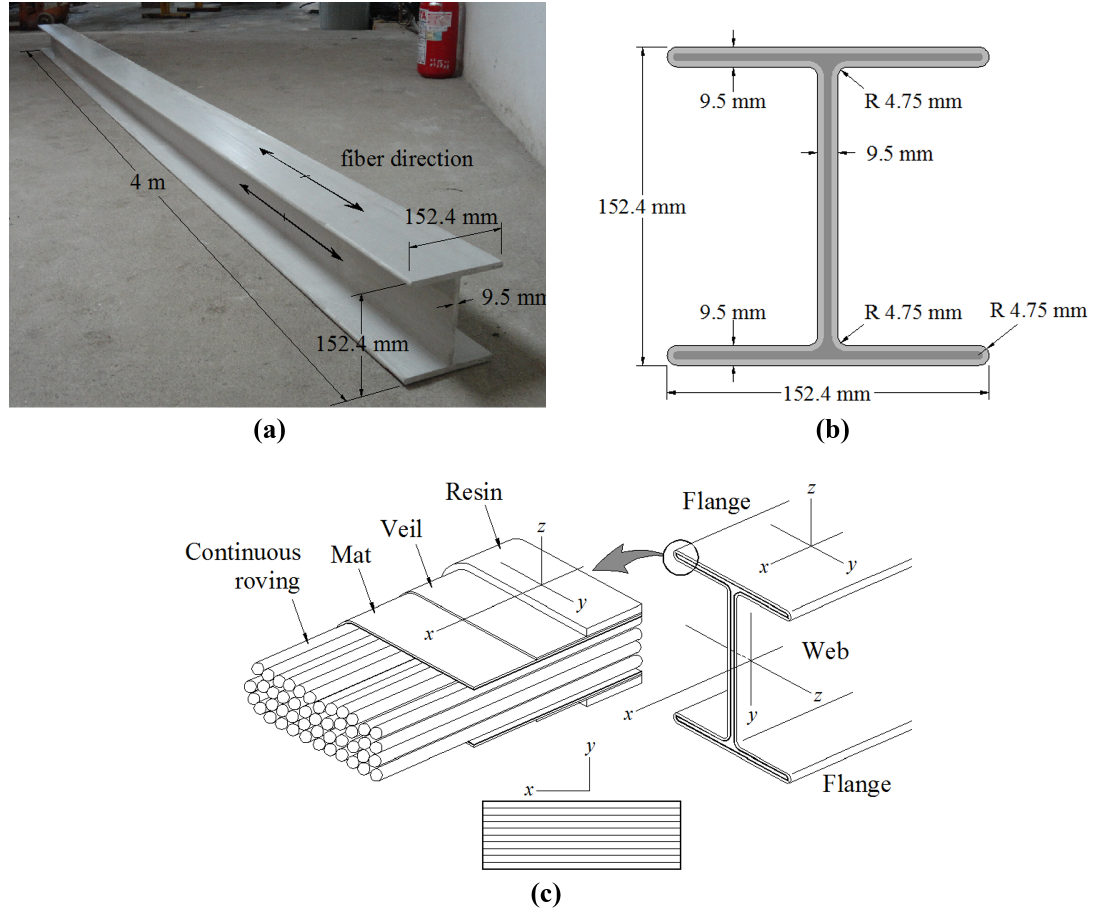
Figure 4. Selected H-shaped GFRP profile - (a) overall view of the member, (b) cross-section dimensions and, (c) GFRP